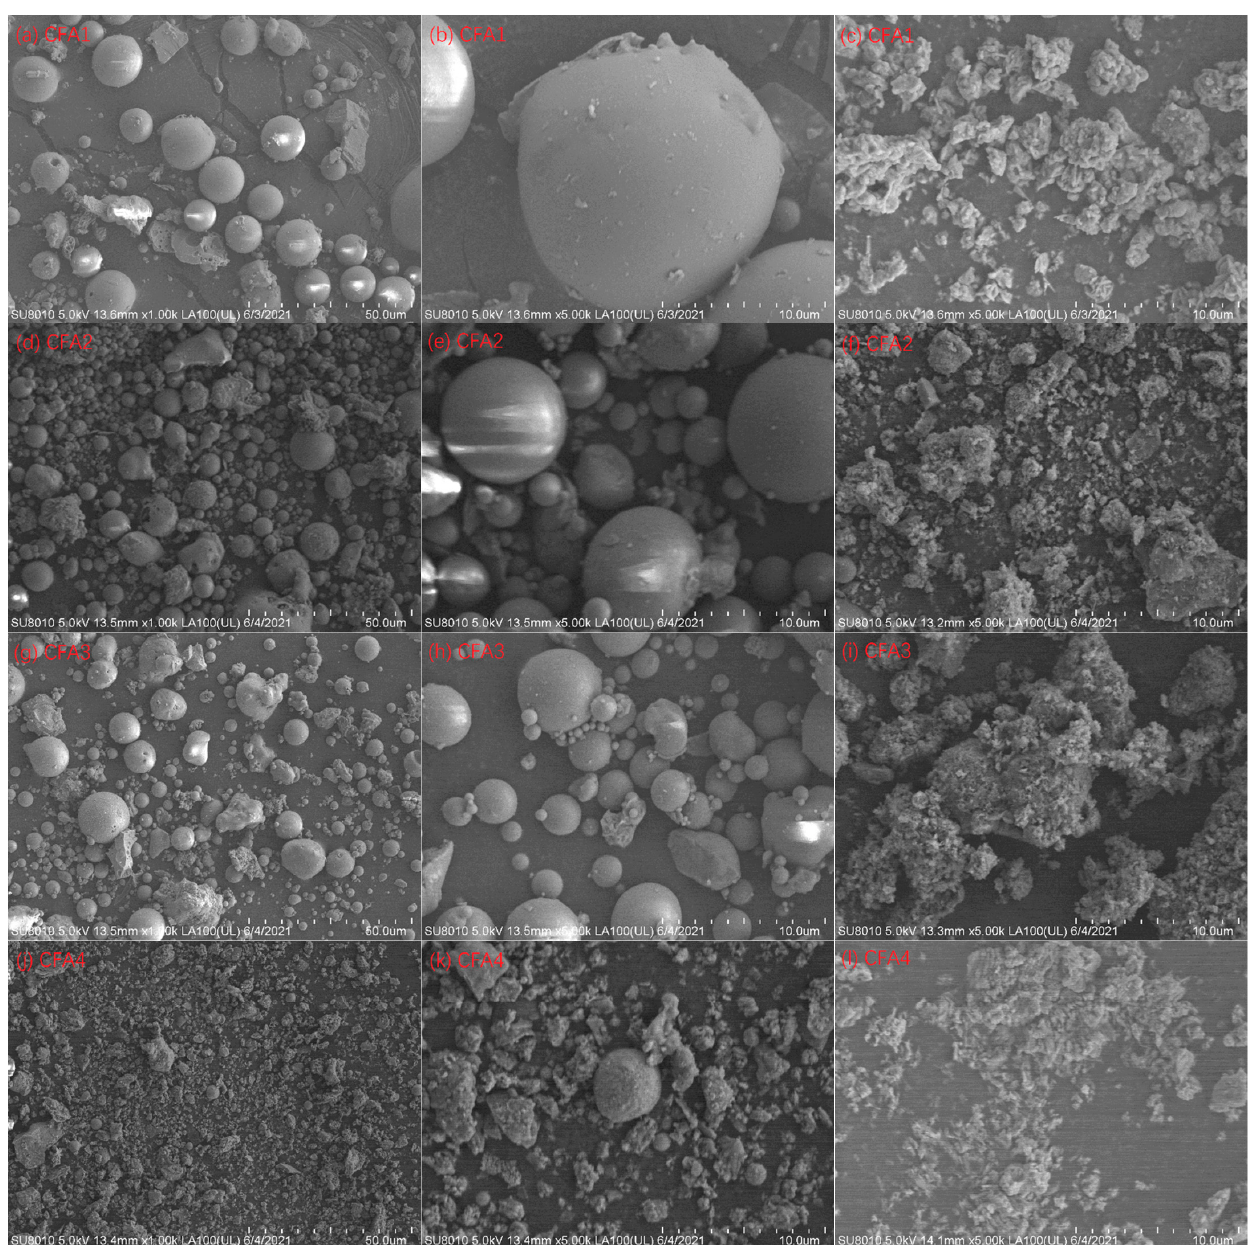
Figure 3. SEM images at 1000 × magnification: ( a ) CFA1, ( d ) CFA2, ( g ) CFA3, and ( j ) CFA4; 5000 × magnification: ( b ) CFA1, ( e ) CFA2, ( h ) CFA3, and ( k ) CFA4; 5000 × magnification: residues of ( c ) CFA1, ( f ) CFA2, ( i ) CFA3, and ( l ) CFA4 after 550 ◦ C of